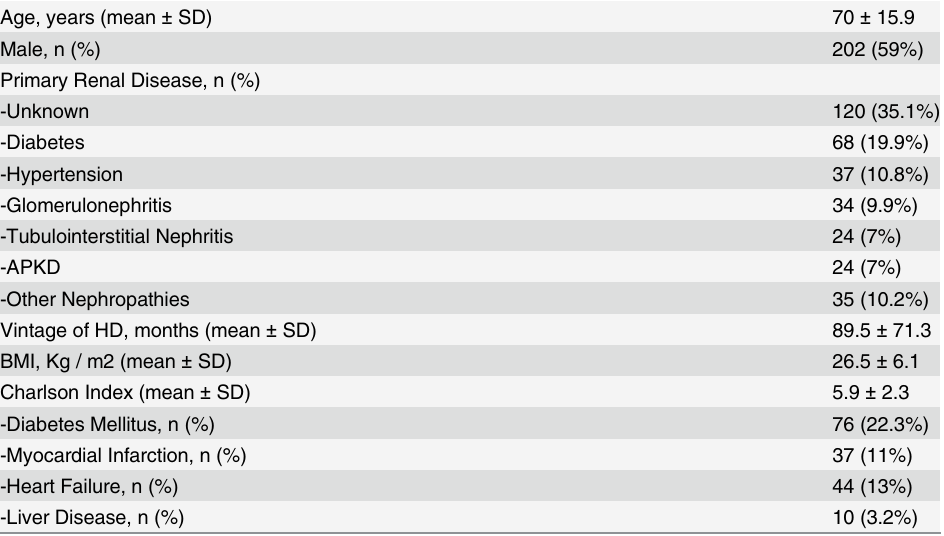
Table 1. Baseline demographic and clinical characteristics of the study population (N = 342